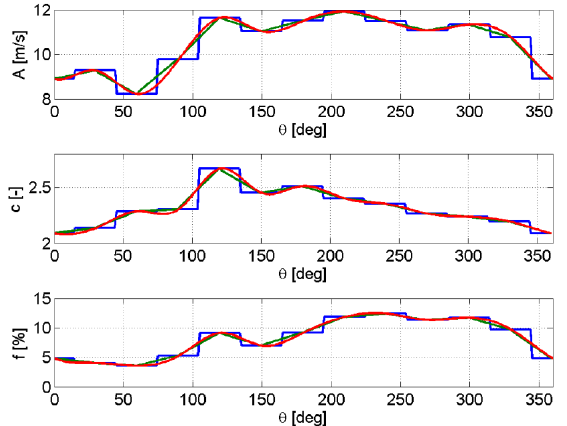
Figure 6. Weibull parameters and frequency of occurrence as functions of wind direction: blue—piecewise in 12 sectors; green—linear interpolation; red—spline